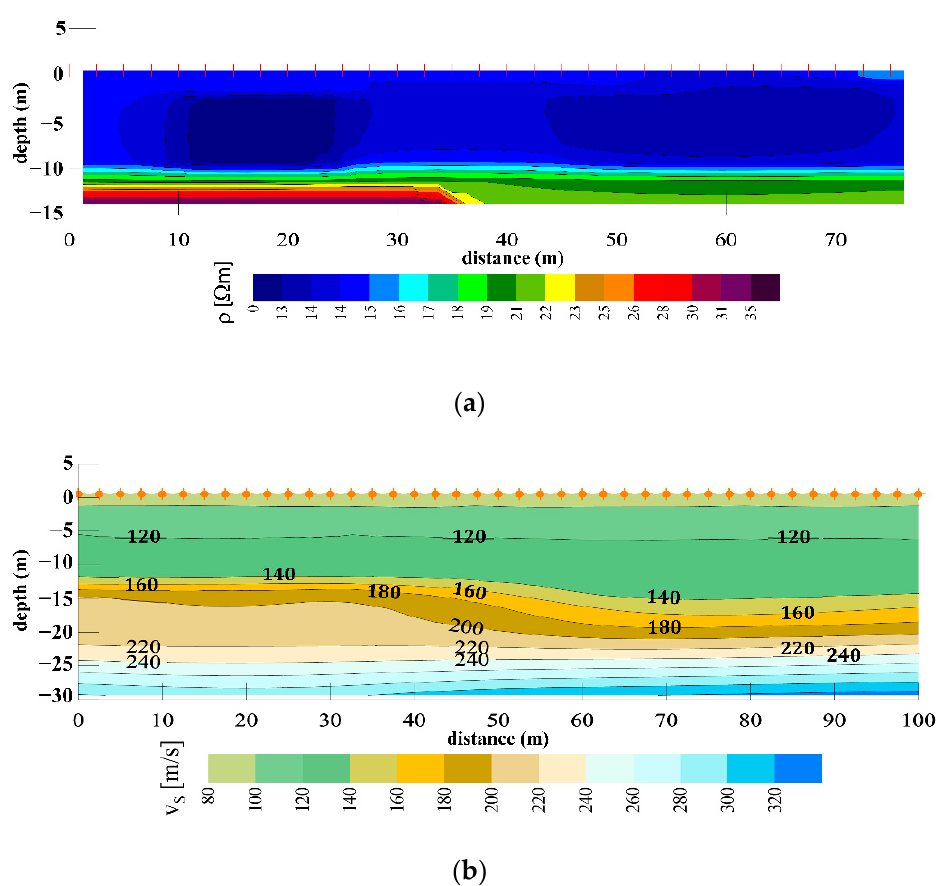
Figure 11. Results of geophysical investigations on profile P1: ( a ) ERT and ( b ) MASW.